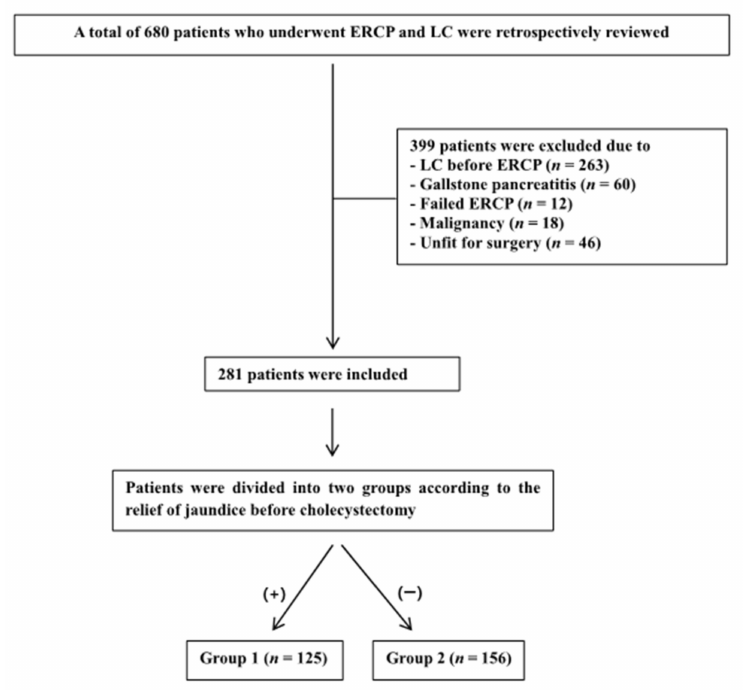
Figure 1. Flow diagram of the study